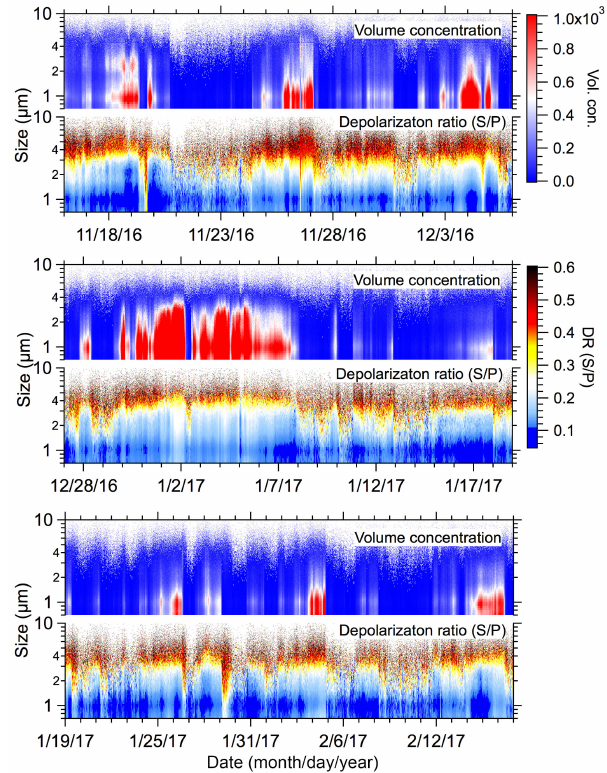
Figure 4. Volume concentrations of particles and corresponding de- polarization ratios as a function of time during observation period. For a better view of the performance of the instrument, the observa- tion results are shown in three time